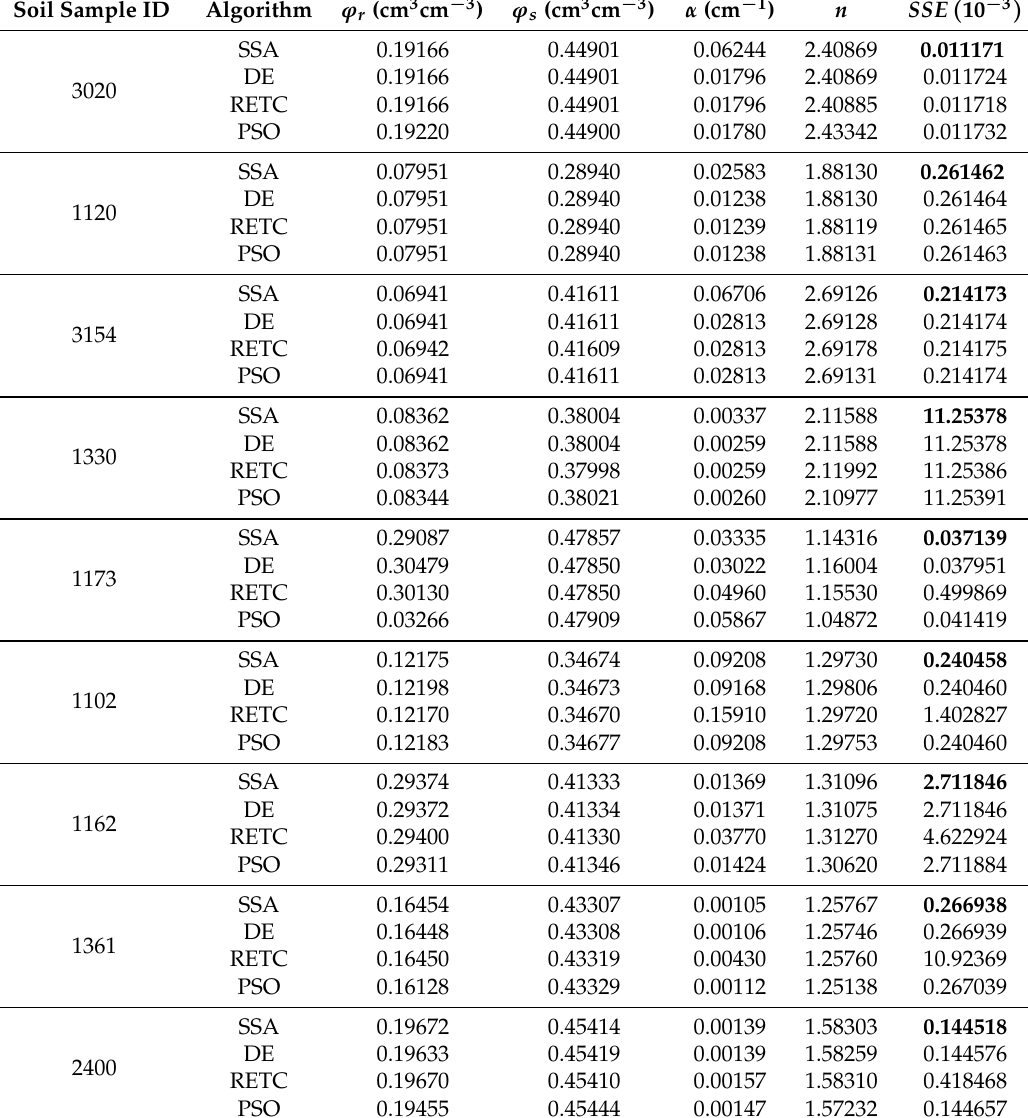
Table 3. Estimated parameters and the sum of squared errors (SSE) of the van Genuchten model using SSA, differential evolution (DE), particle swarm optimization (PSO), and